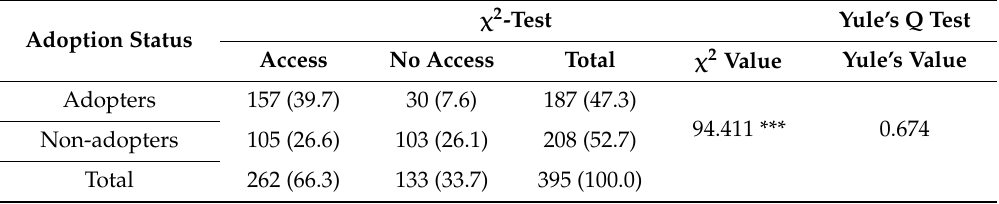
Table 2. Farmers’ credit access and adoption of improved